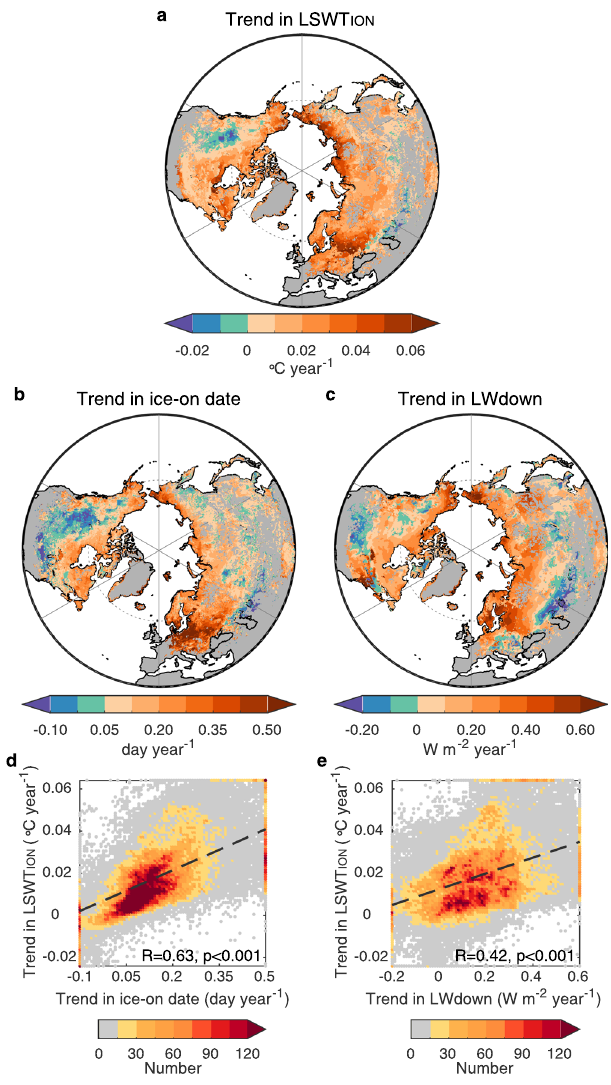
Fig. 3 | Explanationforexcesswarming intheice-onmonth. a – c Spatialpattern of the trend in LSWT ION ( a ), ice-on date ( b ) and downward longwave radiation (LWdown) intheice-onmonth ( c ). d , e Relationshipbetween the trend inLSWT ION ( y -axis) and the trend in ice-on date ( d ) and downward LWdown ( e ) in the ice-on month ( x -axis). The colour of points in d , e shows the number of